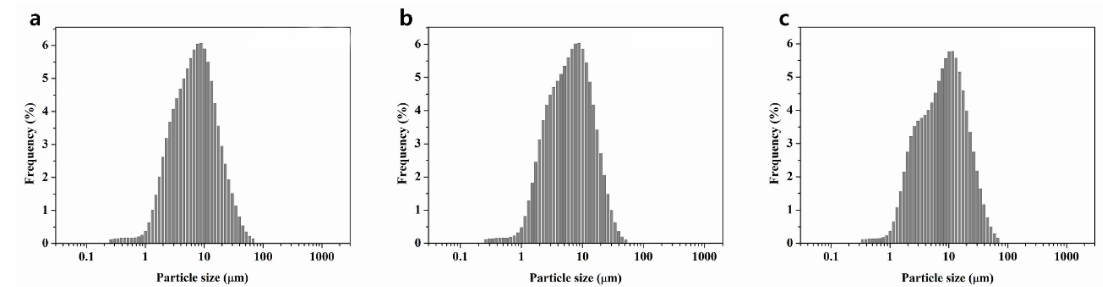
Figure 1. Particle size distributions for three different types of bioactive glass (BAG): ( a ) 45S5 BAG particles; ( b ) 45S5F BAG particles; and ( c ) S53P4 BAG particles.